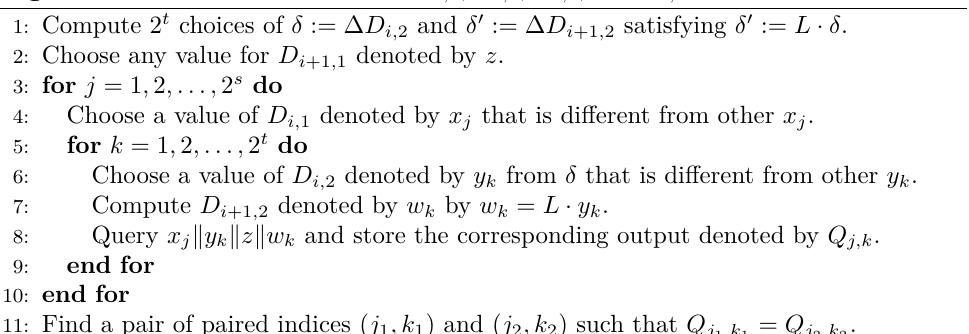
Algorithm 3 Attack for Case 2 with L 2 , 4 , L 1 , 4 , L 1 , 3 , and L 2 , 3 are